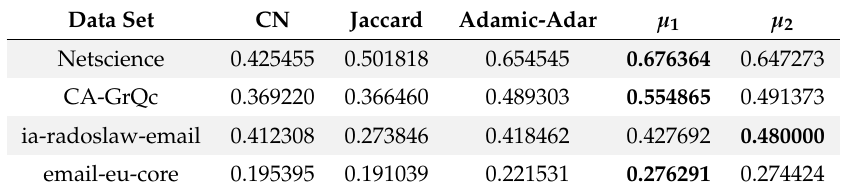
Table 4. Precision of best individual, RAND/1/BIN strategy. Best performance in bold.